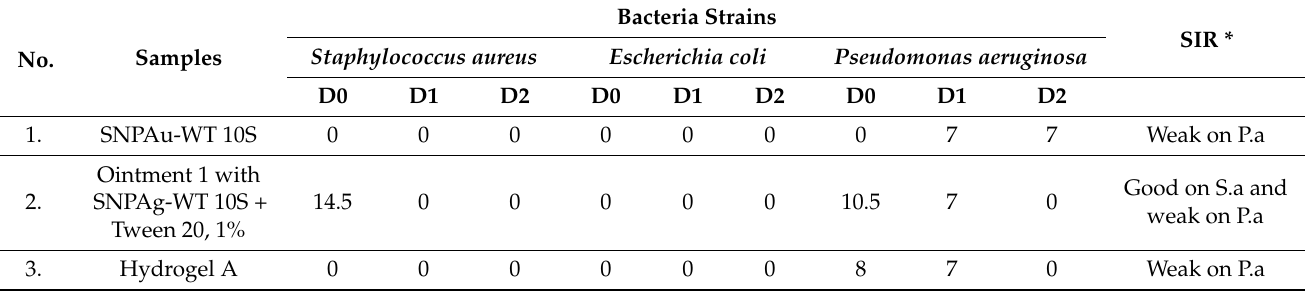
Table 1. SIR interpretation of the mean diameters of the inhibition zone in the diffusimetric antibi- ogram for metal nanoparticles tested on bacteria.